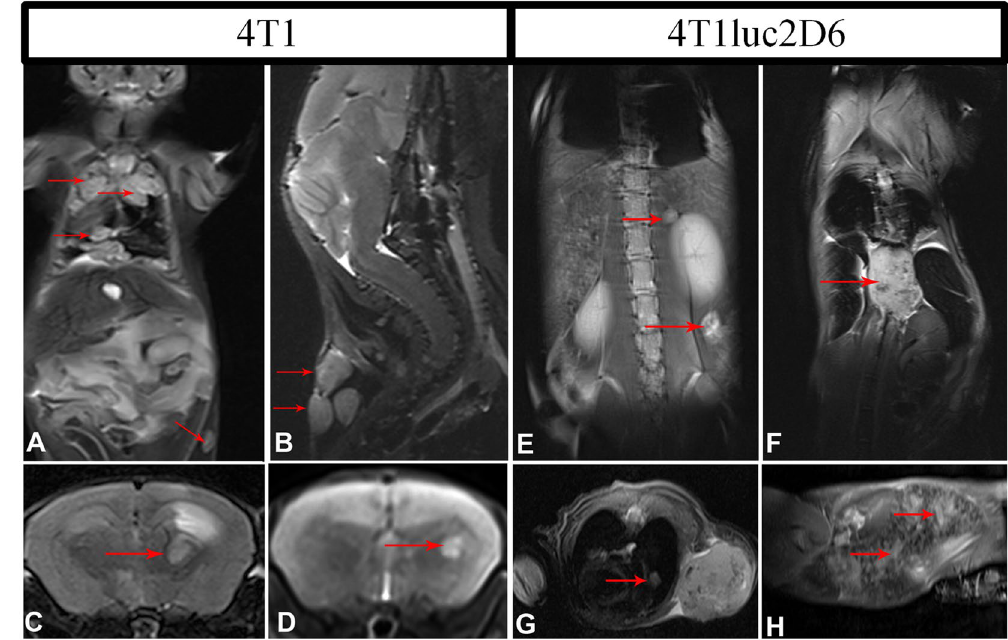
Figure 4. Multiple metastases in BALB/c mice after the orthotopic implantation of 4T1 ( A – D ) or 4T1luc2D6 cells ( E – H ) as visualized by the T2-weighted MRI. 4T1 metastasis in lungs, the lower arrow indicates the metastasis in a lymph node, transversal projection ( A ); Multiple metastatic lesions of the 4T1 primary tumor into the posterior cervical lymph nodes (indicated by arrows), sagittal projection ( B ); Metastatic lesions induced by 4T1 cells in the brain (indicated by arrow) in coronary projections, metastases are manifested by massive perifocal edema ( C , D ); Metastases of 4T1luc2D6 tumor in the retroperitoneal and paravertebral regions, transversal projections ( E and F , respectively); Single metastasis of the 4T1luc2D6 tumor in the lung, coronary projection ( G ); Metastases of the 4T1luc2D6 tumor in the spleen (indicated by arrows), sagittal projection ( H